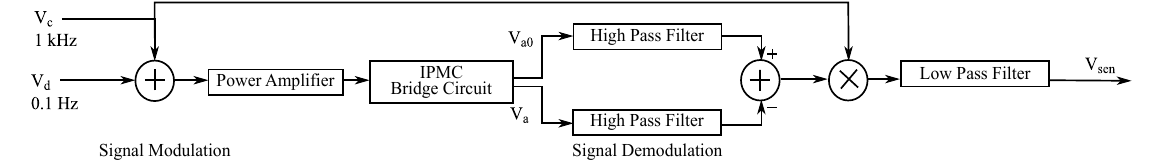
Figure 17. Signal processing implementation for the SSA method in [11] (see Figure 14). Low-frequency actuation voltage is modulated with high-frequency reference to produce a deformation-dependent sensing